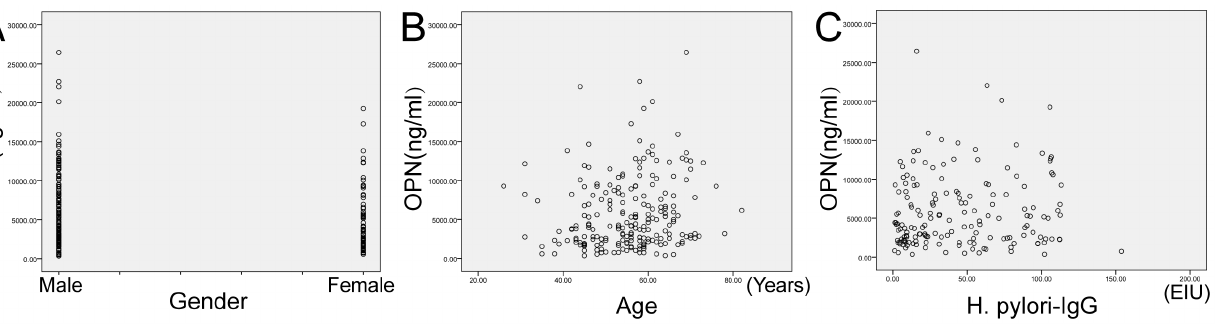
Figure 1. Scatter plots for the correlation between serum OPN and gender, age, H. pylori infection, in gastric cancer group. A, Gender; B, Age; C, H.pylori infection.